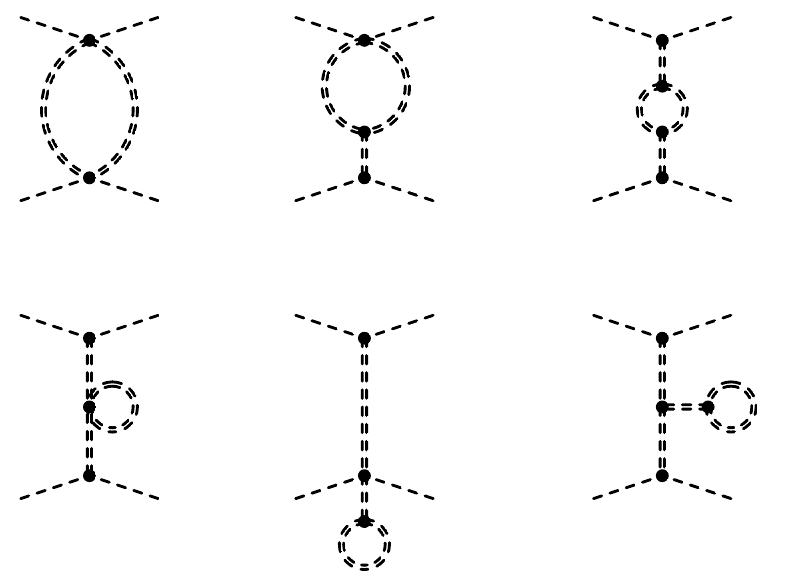
Figure 2 . Examples of heavy contributions to the one-loop matching correction C (1) styles and their meanings resemble those of (cid:12)gure